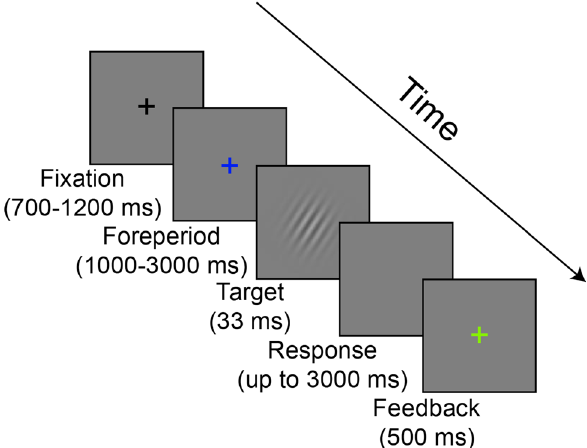
Figure 2. Trial progression. Exemplary trial with a correct response. In incorrect response trials or in trials where no response was given within 3000 ms, the feedback was colored red. The foreperiod prior to target onset was determined according to condition, as depicted in Table 1. Stimuli are shown for illustration purposes only and are not to scale.